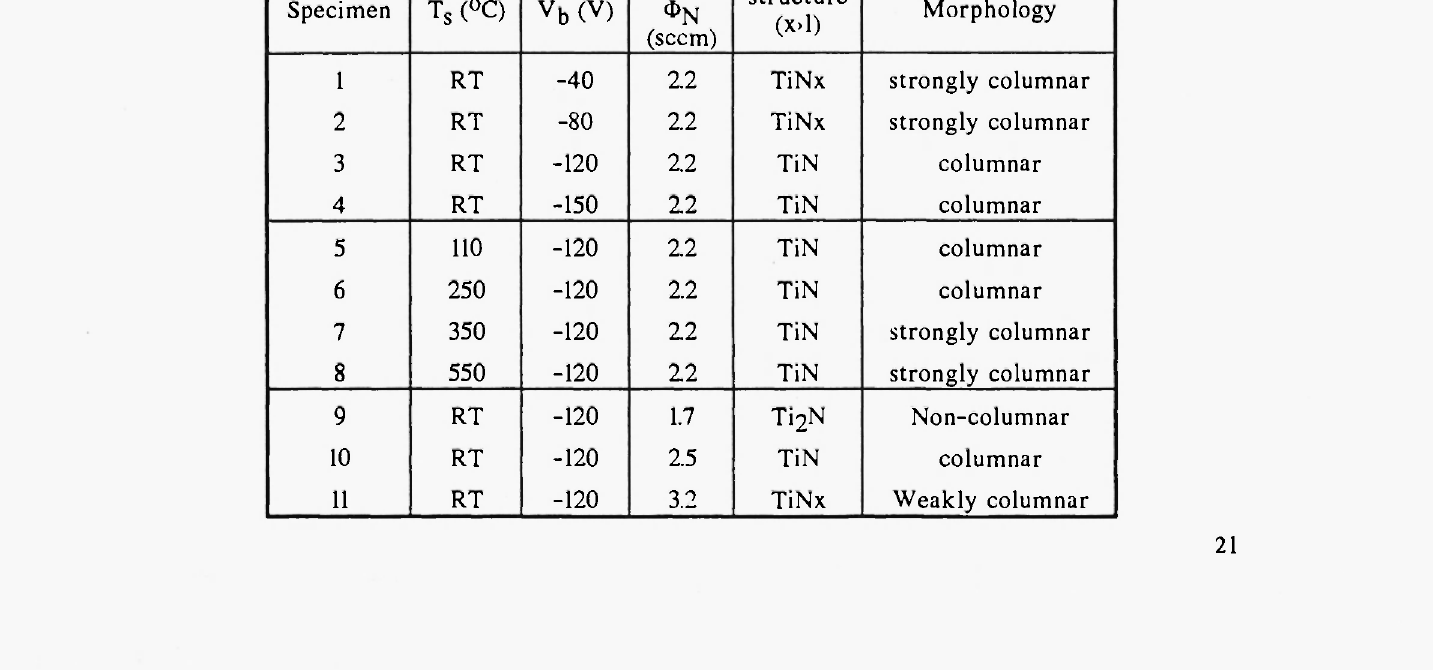
TABLE I. Microstructural characteristics and structure versus deposition conditions of